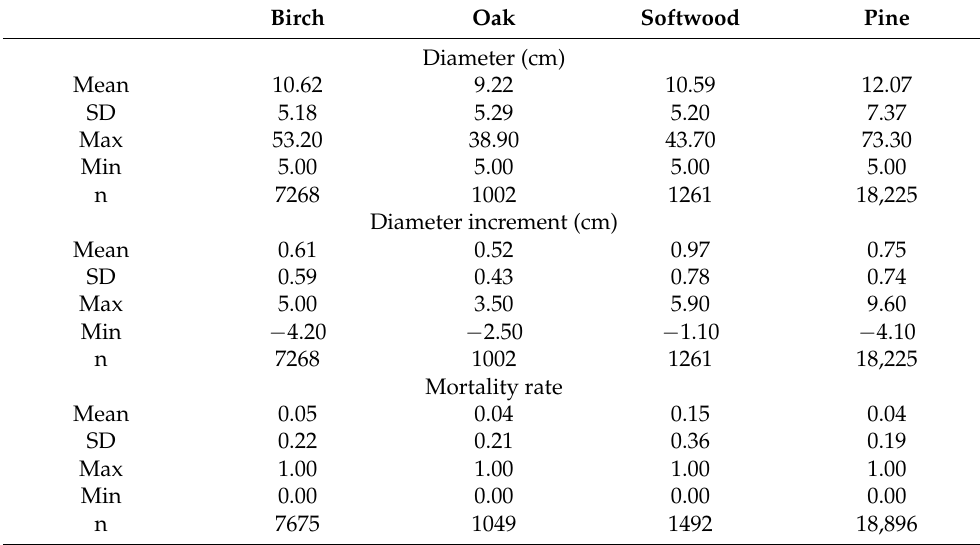
Table 3. Summary of individual trees. The diameter was recorded in the first inventory. Tree mortality rate and diameter increment were derived from the two inventories; n represents the total number of